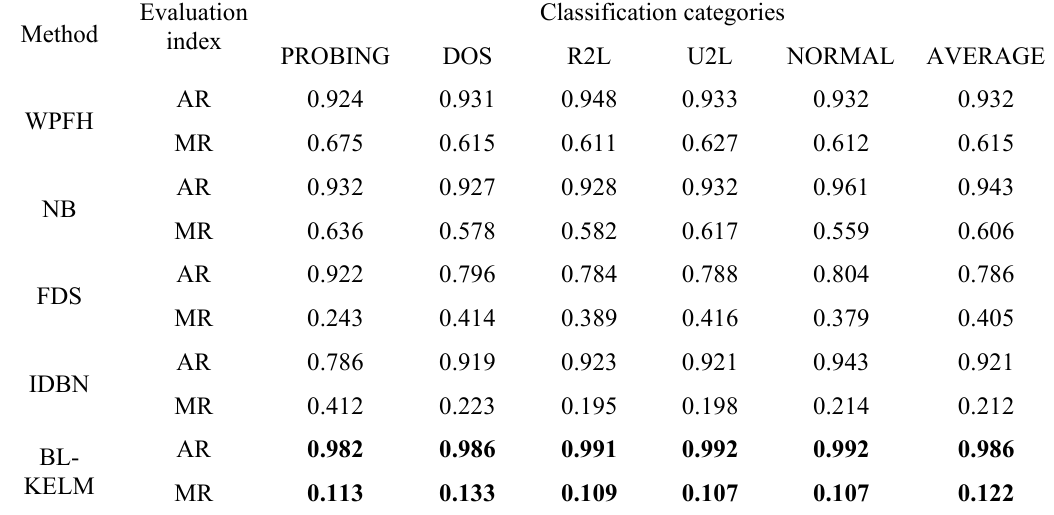
learner algorithm and the common integrated learning algorithm on the unknown types of intrusive connections. The experimental results are shown in table 6. Table 6. Unknown intrusion detection with